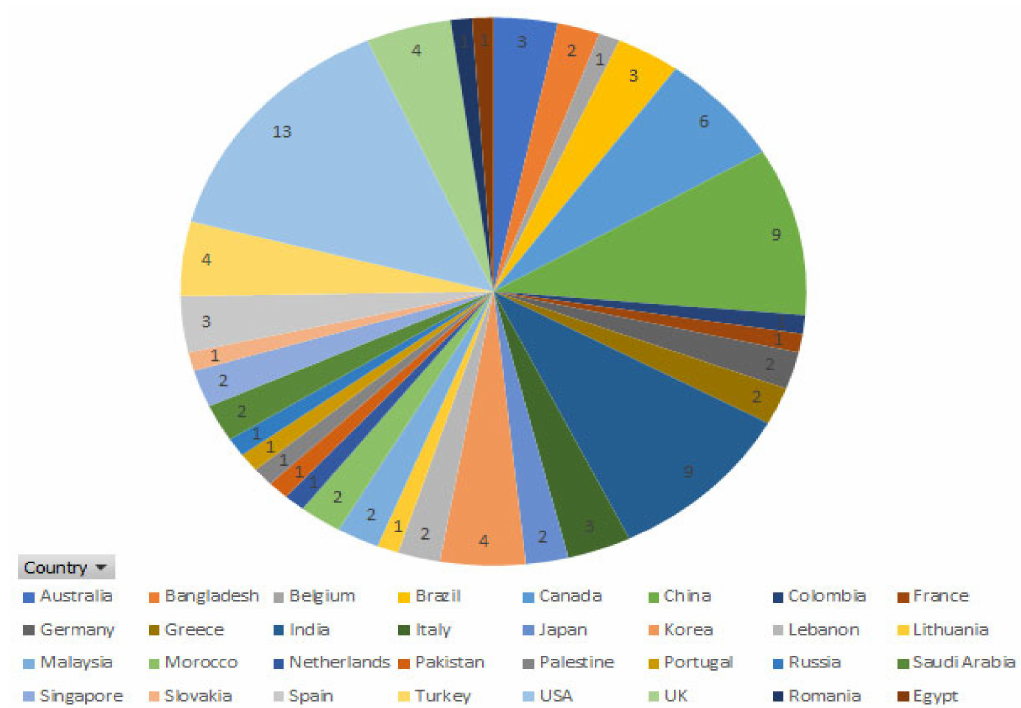
Figure 2. Number of publications for each country.